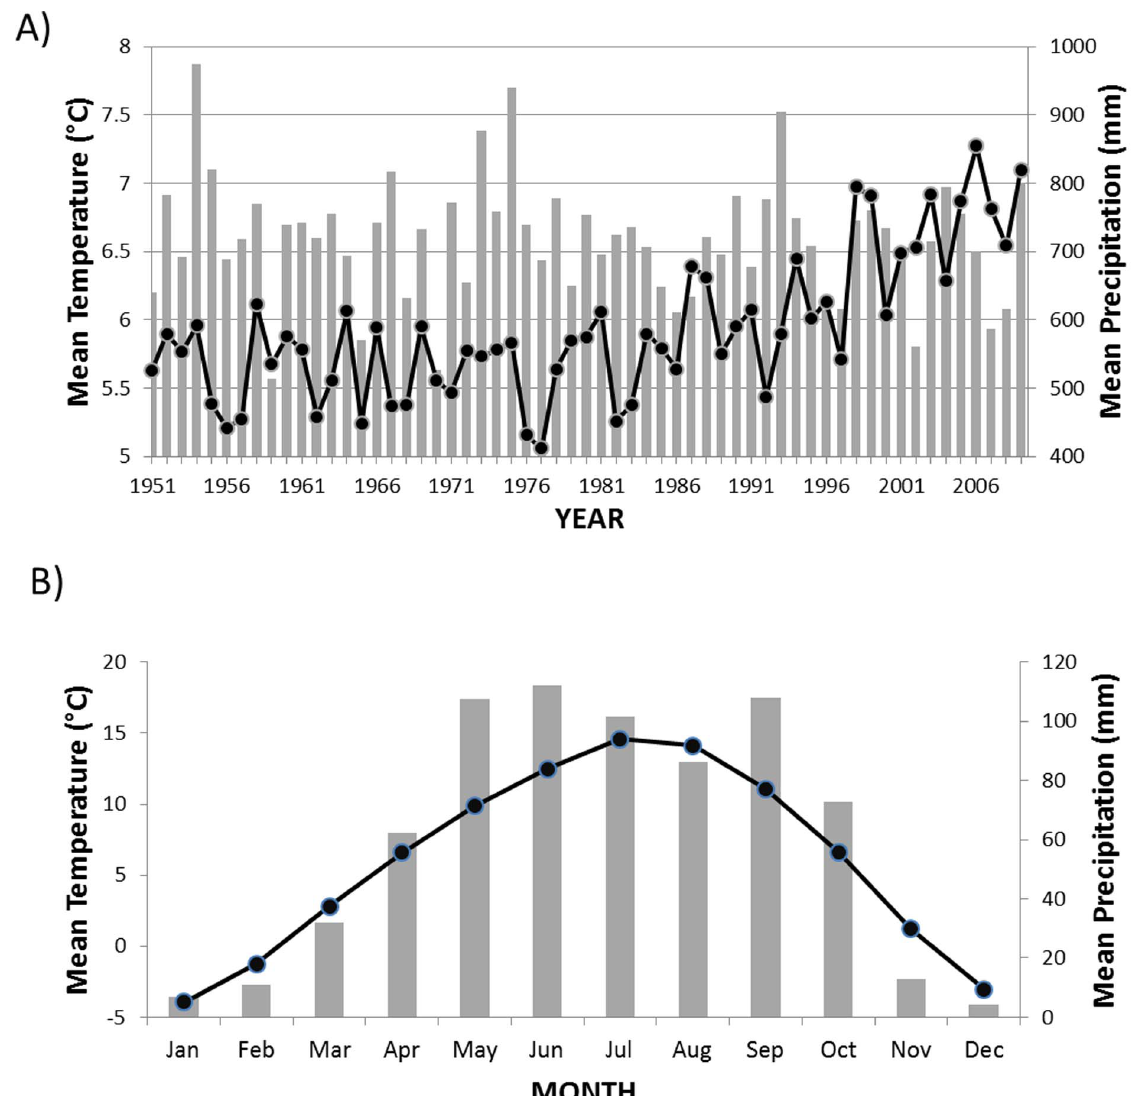
Figure 2. A regional climate summary for Jiuzhaigou National Nature Reserve. Annual (A) and monthly (B) climate summaries from the Songpan meteorological station (32.65N 103.56E, 2852 m elevation). This station is the longest-running station near Jiuzhaigou National Nature Reserve (JNNR). Mean temperature (dots; left axis) and precipitation (grey bars; right axis), 1951–2009. Data are from the Chinese Meteorological Association [37].